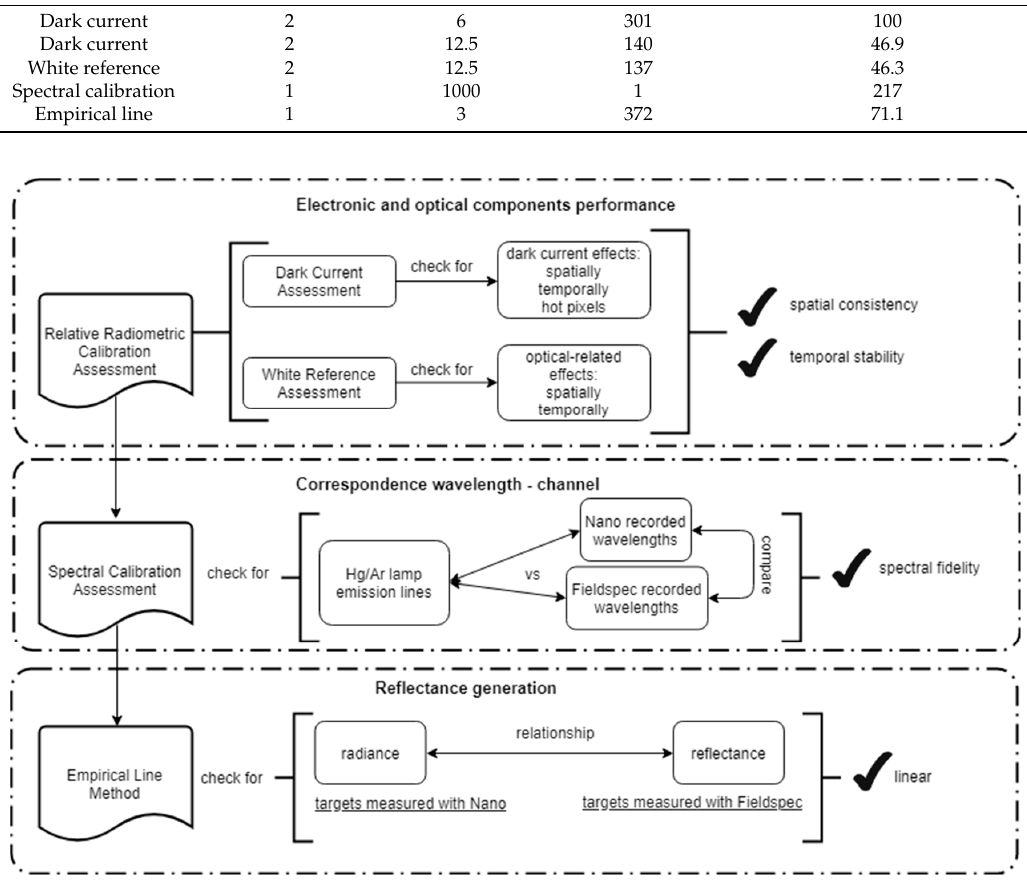
Figure 1. Figure 1. Workflow used in this study for assessing the performance of the push-broom hyperspectral sensor.